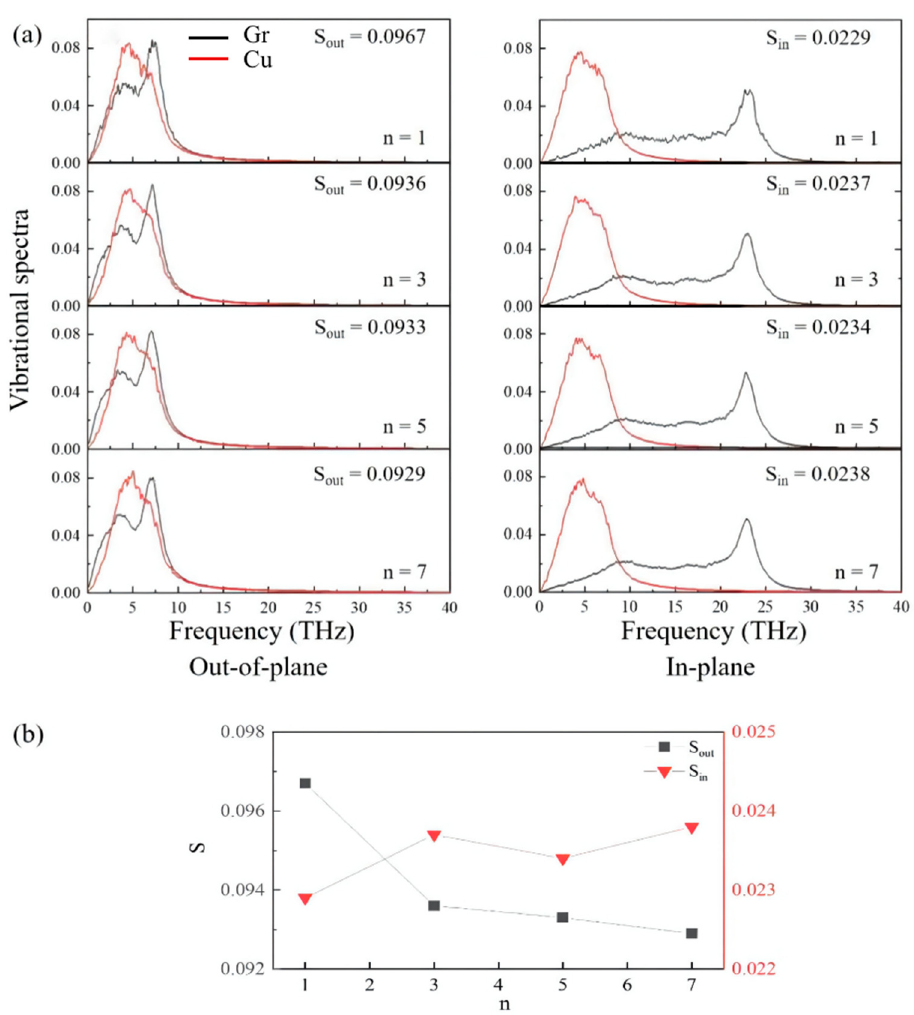
Figure 3. ( a ) Vibrational spectra of different modes of Cu and graphene atoms at the interface; n depicts the number of graphene layers. ( b ) The overlap concentration of phonon spectrum S with different layers; S out and S in represent the corresponding values of in-plane and out-of-plane modes, respectively.